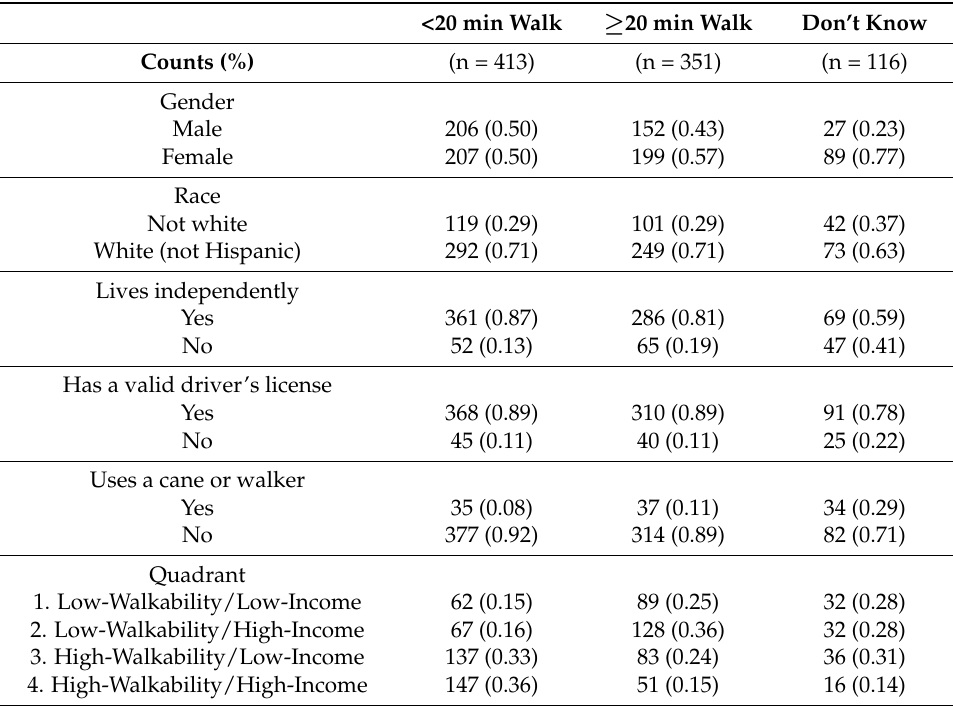
Table 1. Individual and neighborhood characteristics of participant population, by perceived walking time to closest supermarket retailer. NEWS: Neighborhood environment walkability survey, BMI: Body mass